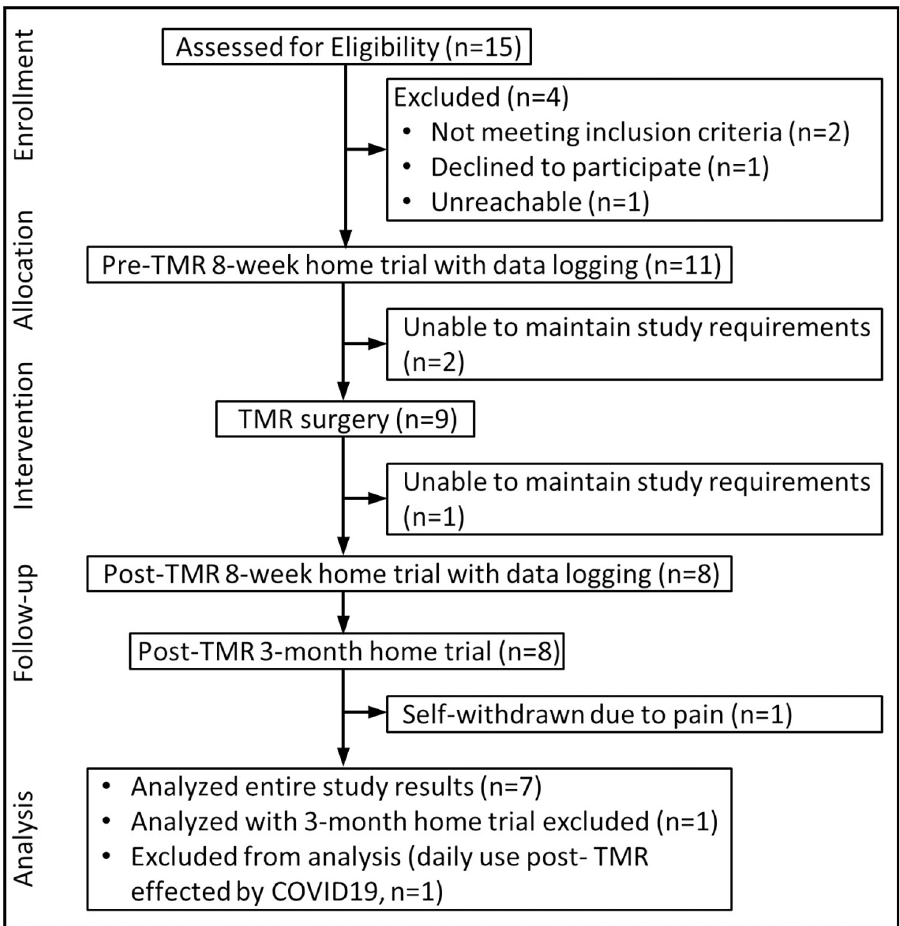
Fig 1. Participant flow diagram of enrollment, allocation, follow-up, and